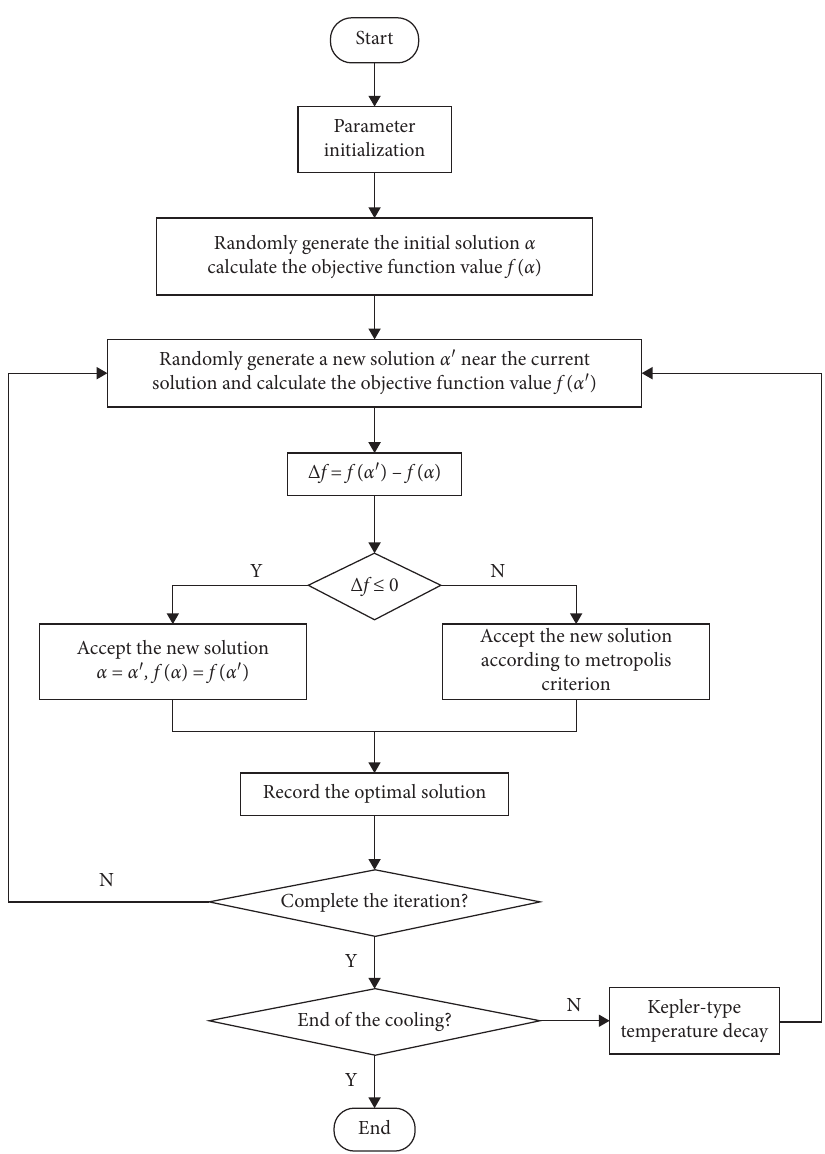
Figure 9: Flowchart of the proposed SA